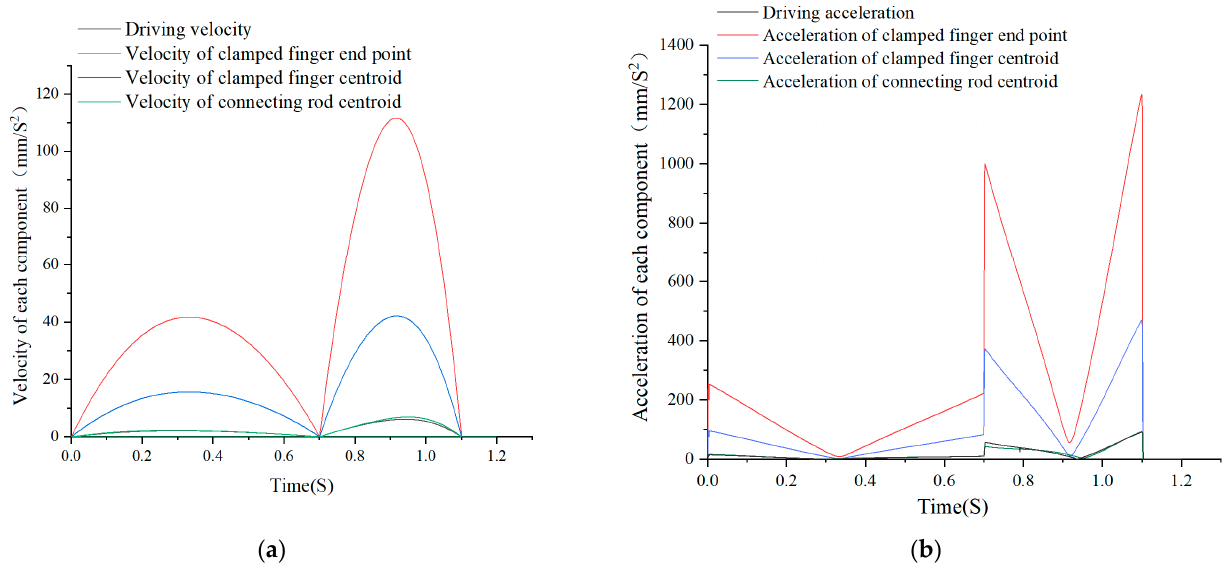
Figure 13. Simulation results for each component of end effector. ( a ) Velocity of each component. ( b ) Acceleration of each component.